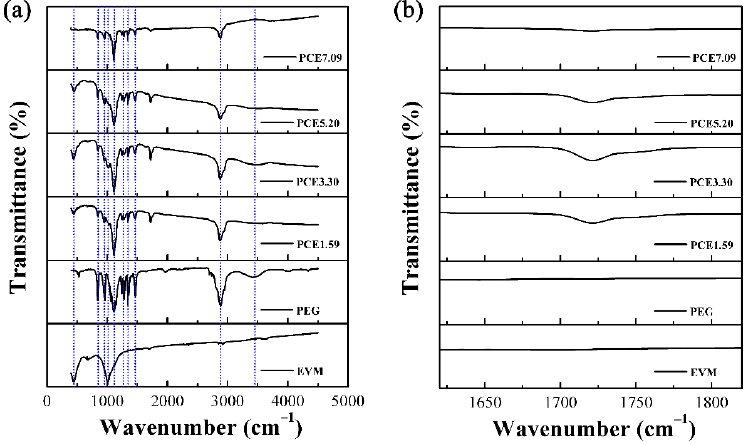
Figure 5. ( a ) Fourier transform infrared (FT-IR) spectra of EVM, PEG, and PCE-CPCMs, ( b ) enlarged at 1620–1820 cm − 1 .